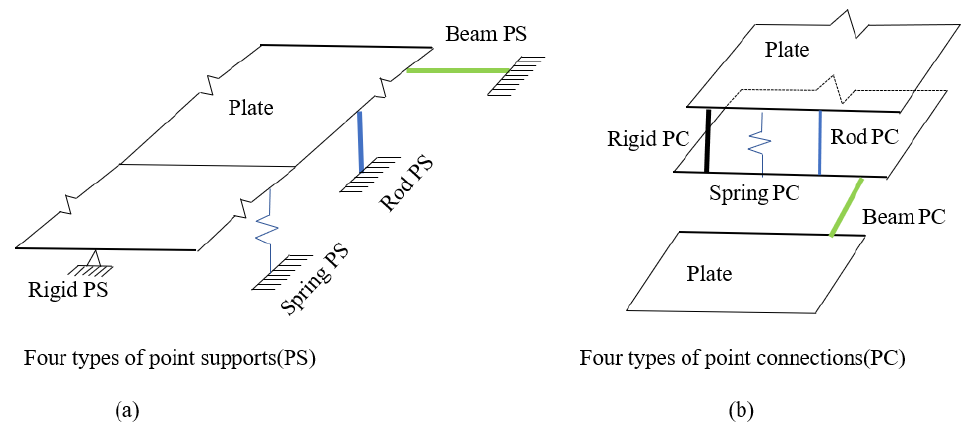
Figure 1. Four types of point supports (PS) and four types of point connections (PC): ( a ) Plates supported by four types of connections; ( b ) Plates coupled by four types of